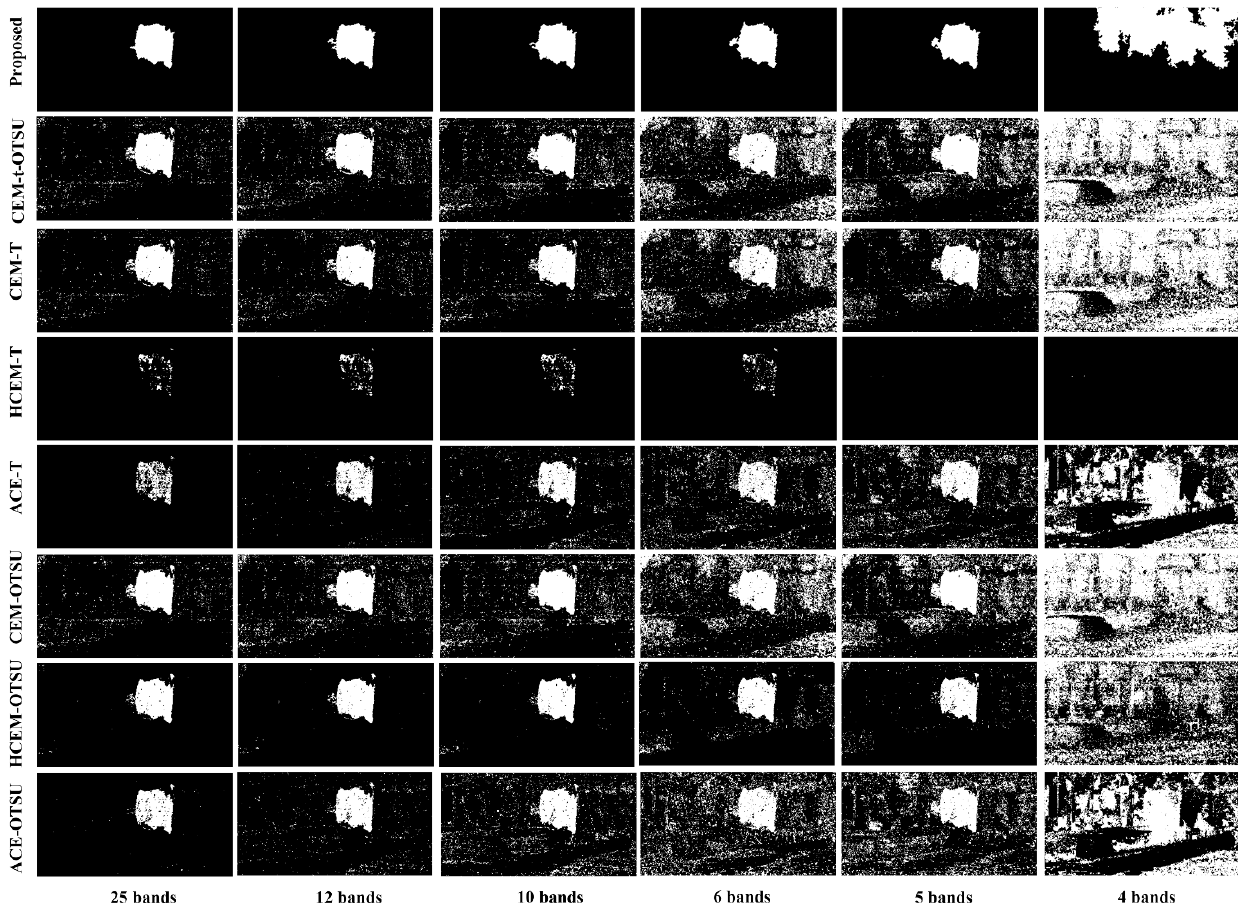
Figure 12. The detection results of different methods for the AIRC-net in the BT scene with bands ranging from 4 to 25. All the results are normalized to [0,1] for a fair comparison.